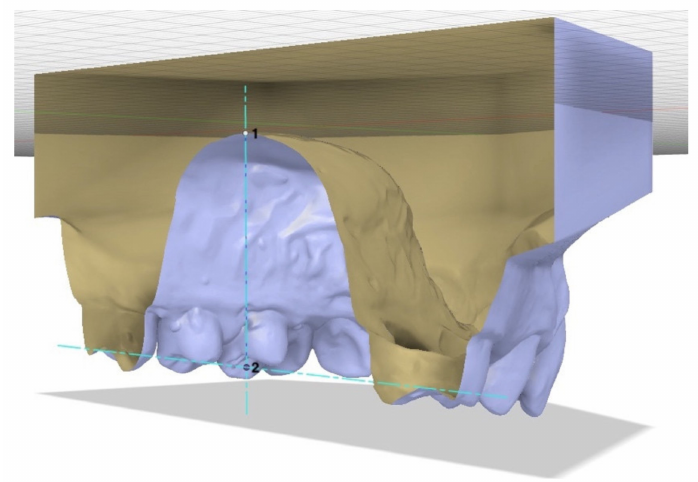
Figure 2. The palatal height is the perpendicular to the median plane of raphe drawn from palatal surface (point 1 ) up to the level of occlusal plane (point 2